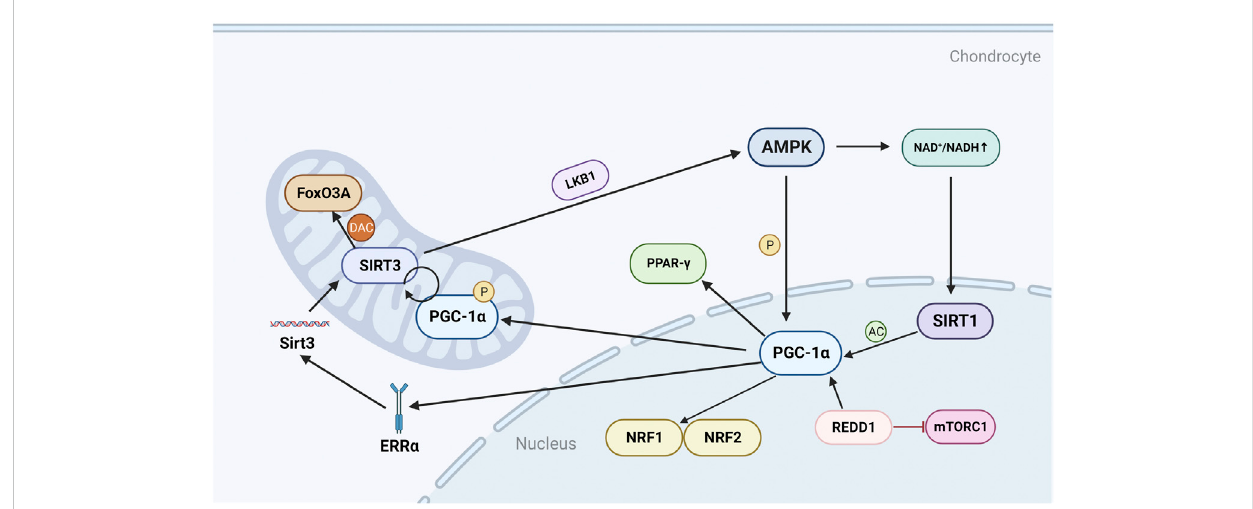
FIGURE 1 Regulatory mechanisms and molecules of PGC-1 α in chondrocytes. AMPK can directly phosphorylate and activate PGC-1 α , and can also activate SIRT1 by regulating NAD + /NADH, thereby acetylating and activating PGC-1 α ; PGC-1 α can further promote the production of NRF1, NRF2 and TFAM; REDD1 is an endogenous inhibitor of mTOR and can regulate the transcriptional level of PGC-1 α ; PGC-1 α can positively regulate SIRT3, and can also promote the expression of Sirt3 gene by mediating ERR α ; SIRT3 can deacetylate FoxO3A in the mitochondrial matrix, and can also activate LKB1 to form a positive feedback loop to promote the expression of AMPK. P, phosphorylate; AC, acetylation; DAC,